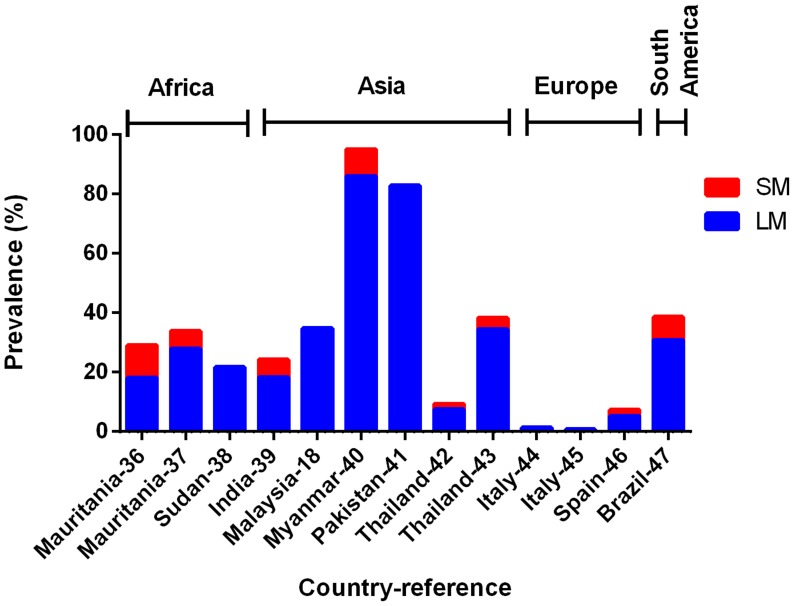
Prevalence of LM (light microscopy, blue bar) and SM (sub-microscopy, red bar) P. vivax in clinical malaria suspects.Total height of the bar (blue + red) represents the PCR prevalence.